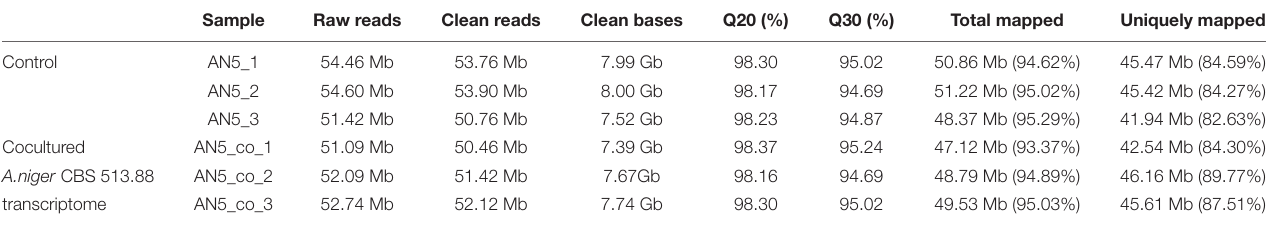
TABLE 4 | RNA-Seq clean reads and the counts, percentage of reads mapping statistics to Aspergillus niger CBS 513.88 genome. Sample Raw reads Clean reads Clean bases Total mapped Uniquely